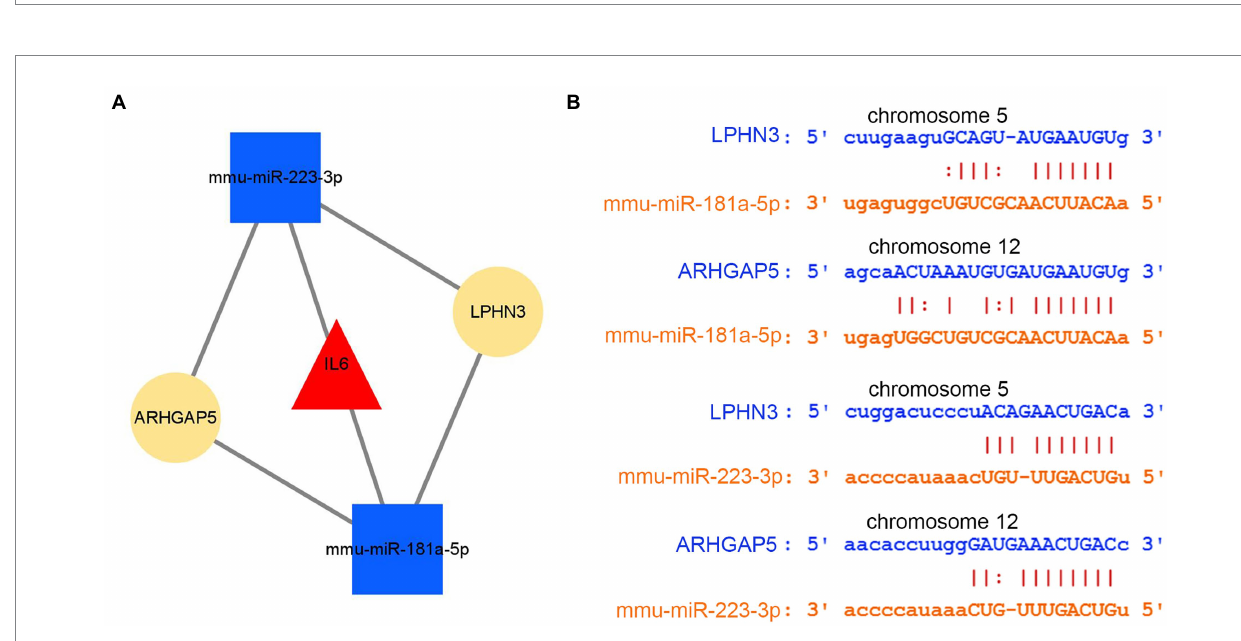
FIGURE 10 The analysis of circRNA-miRNA-mRNA network. (A) The circRNA–miRNA-hub gene network. (B) The interaction of novel circRNAs/DEmiRNAs.